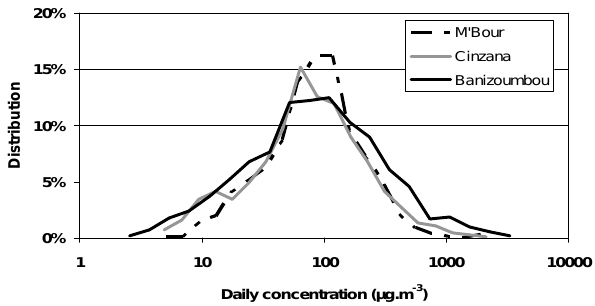
Fig. 2. Relative distribution of the daily mean PM 10 concentrations from the three stations of the SDT between January 2006 and De- cember 2008.